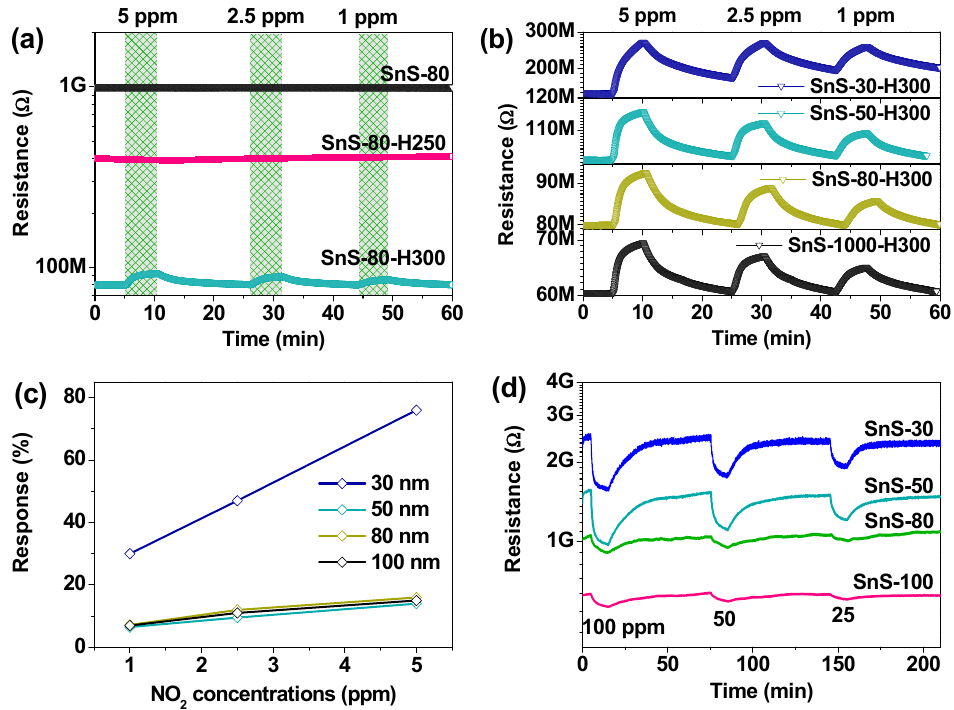
Figure 7. ( a ) Real-time resistance curves obtained under different NO 2 concentrations for as-deposited SnS-80, SnS-80-H250, and SnS-80-H300 sensors. ( b ) Response curves for various concentrations of NO 2 gas of SnS sensors with different thicknesses annealed at 300 °C. ( c ) Corresponding responses of the sensors as derived from (b). ( d ) Dynamic response curves for as-deposited SnS thin-film sensors with different thicknesses showing p-type sensing behavior toward high-concentration NO 2 gas. All gas-sensing measurements were conducted under UV illumination at RT (25 °C) .